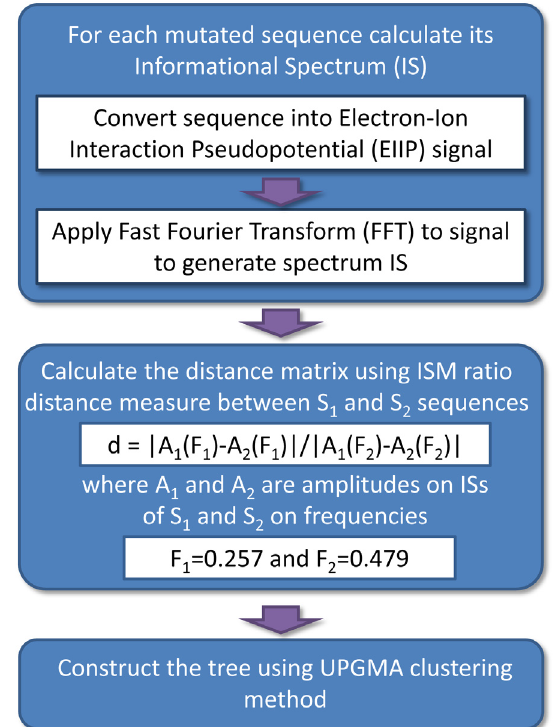
Figure 1. The schematic representation of the ISM-based phylogenetic algorithm ISTREE.